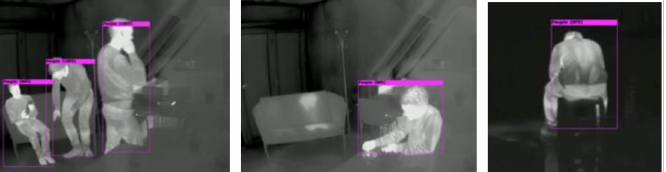
Figure 13. Detection of ready-to-sit, sitting, occluded sitting human, and human sitting backwards.